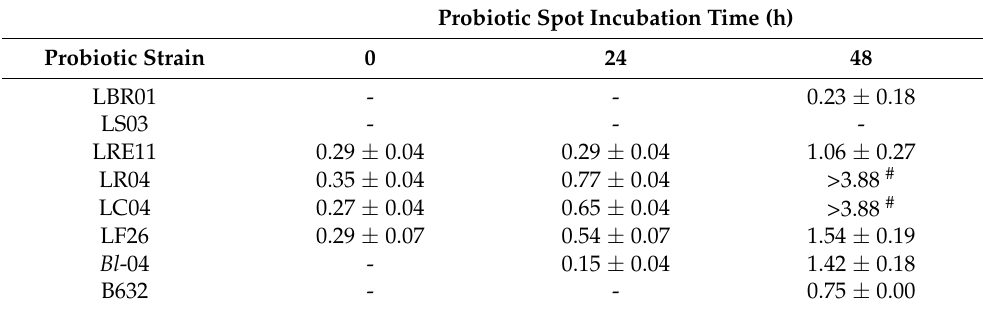
Table 2. Normalized width measurement in mm of inhibition halos obtained in the complex agar spot test. Probiotic Spot Incubation Time (h) Probiotic Strain 0 24 48 LBR01 - - 0.23 ±